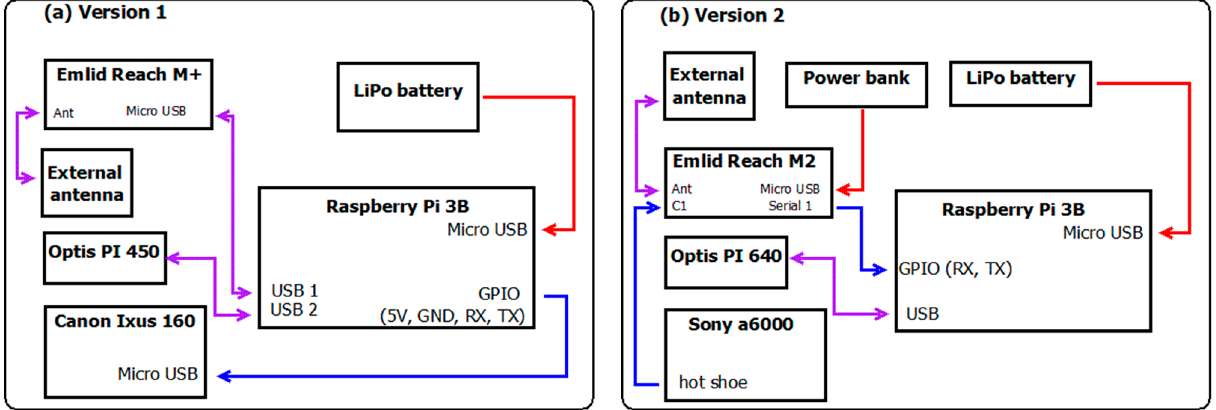
Figure 2. Schematics of the thermal camera system. The arrowheads indicate the direction of communication. Red arrows indicate power supply, blue arrows indicate data stream, purple ones indicate power supply and data stream together. Version 1 ( a ) was used in the first year of the study. After changing some parts of the system, Version 2 ( b ) was used in the 2nd year.